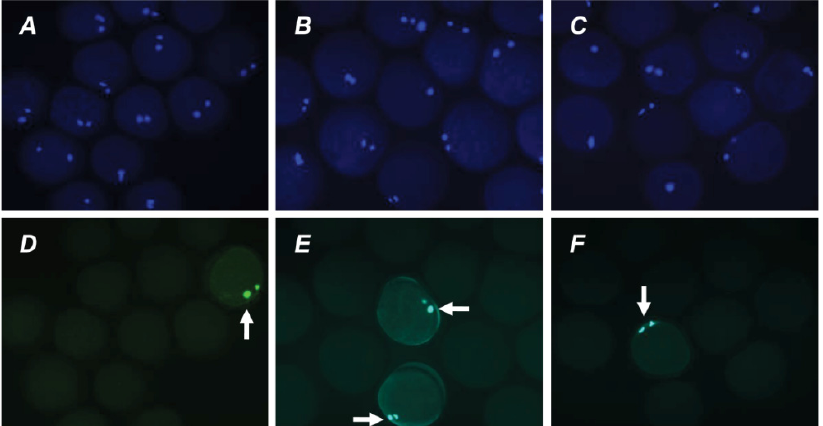
Figure 6. Representative images of apoptosis in matured or aged bovine CEOs. ( A , D ) Matured oocytes prior to aging. ( B , E ) Oocytes aged in the control medium. ( C , F ) Oocytes aged in the presence of PRL. ( A – C ) DAPI staining (blue). ( D – F ) TUNEL staining (green). TUNEL-positive chromosomes are indicated by white arrows. Original magnification: ×200.